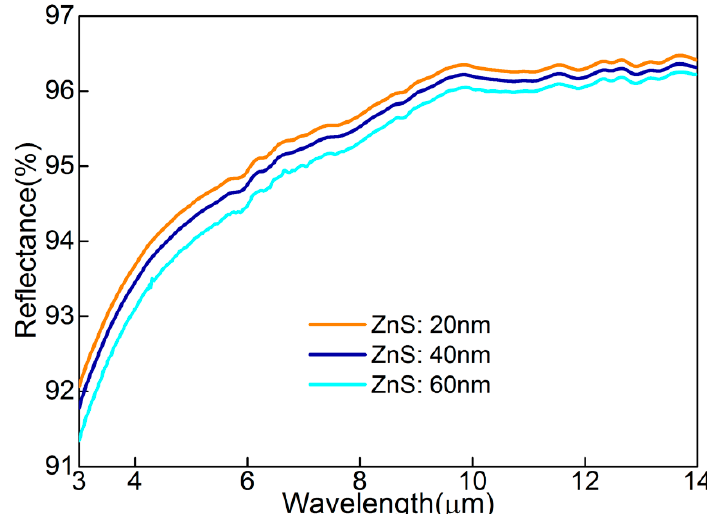
Figure 4. The experiment measured infrared reflection spectrum for the 3–14 μ m range for d ZnS = 20, 40, and 60 nm.